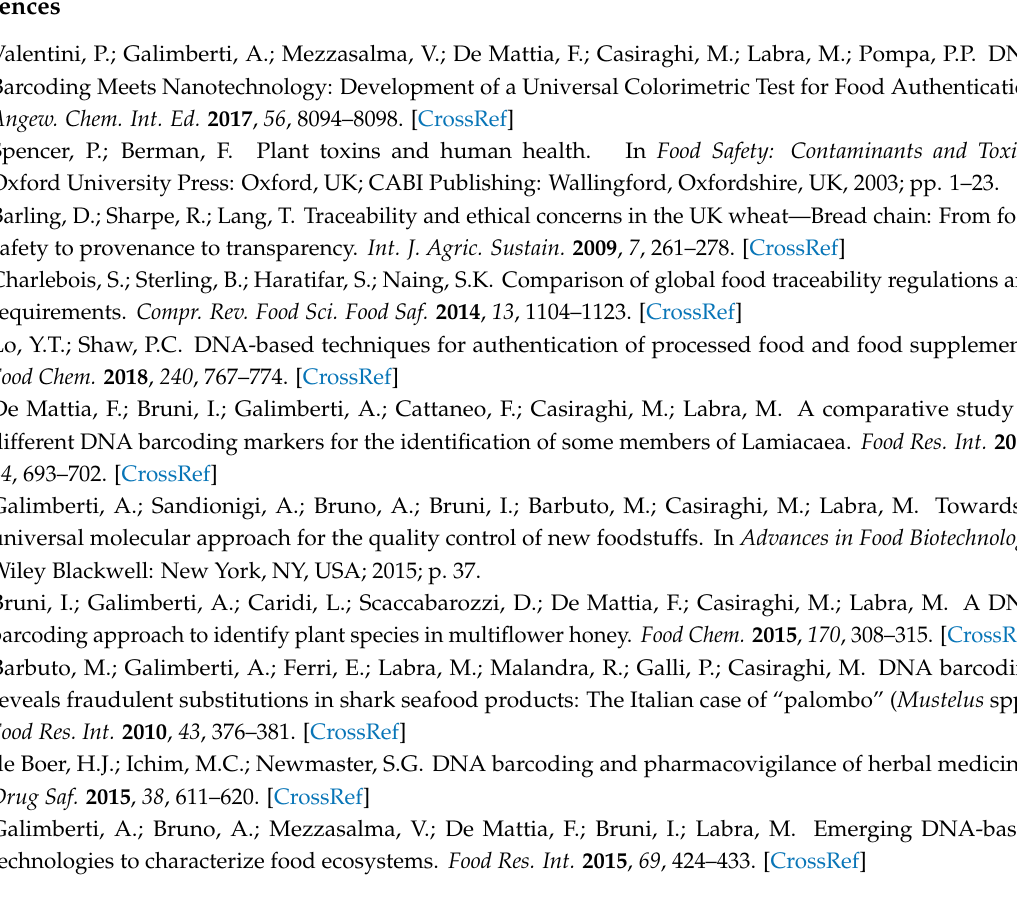
Table S1: Amounts of DNA of each species in the five different mix of mock herbal mixture; Table S2: different concentrations of DNA, based on qPCR quantifications of each mix in mock herbal mixture; Table S3: List of barcodes used for Illumina sequencing; Table S4: Bray-curtis distance matrix of fruit mixture samples; Table S5: OTU table of mixed fruit with taxonomic annotation; Table S6: OTU table of preocessed food with taxonomic annotation; Table S7: Regression results of mixed fruit